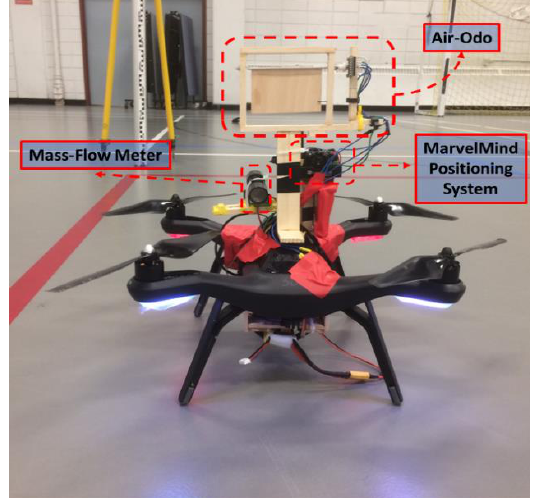
Figure 8. 3DR quadcopter equipped with all the equipment (Air- Odo, Mass-Air flow, and MarvelMind indoor positioning system) for the indoor flying experiment